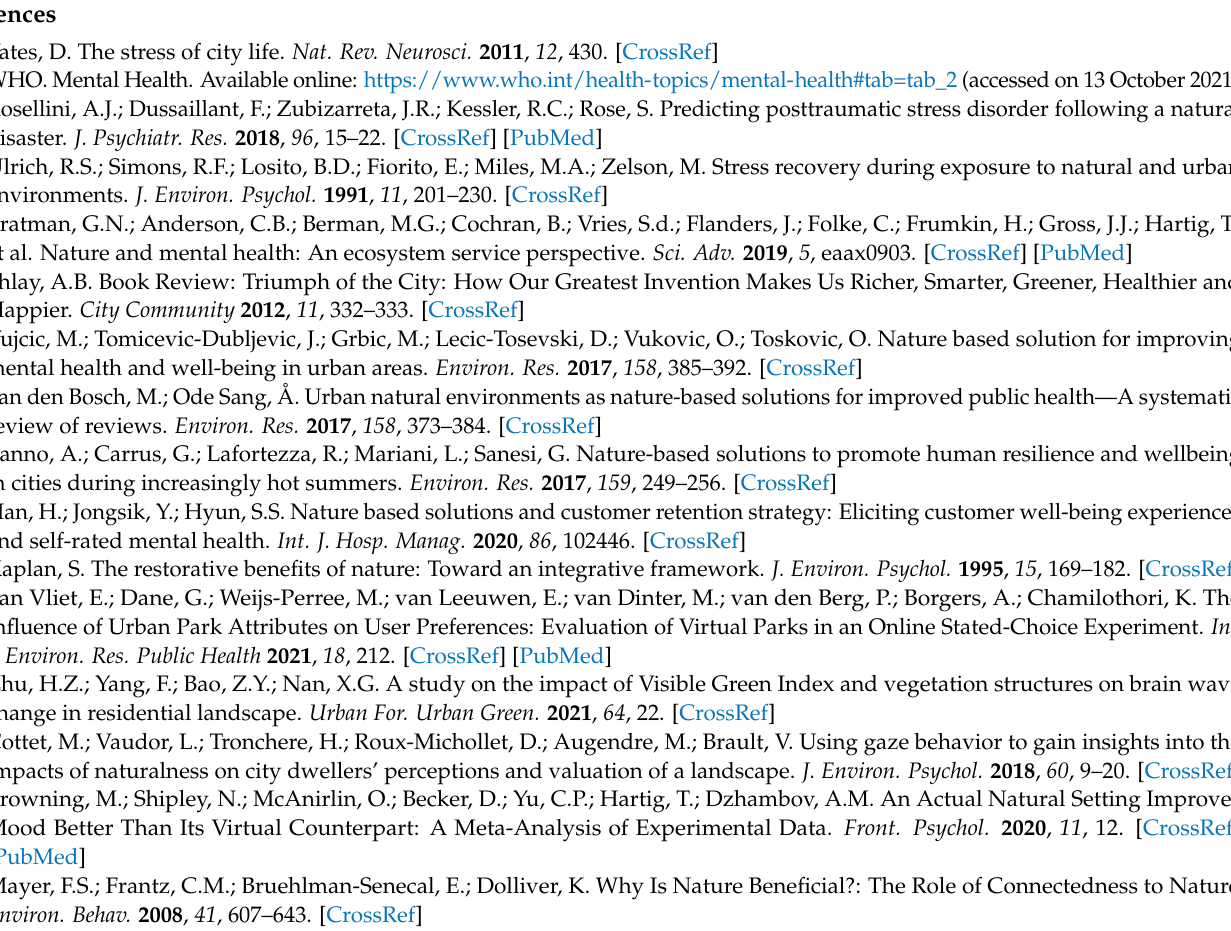
Figure S2: Spatial distributions of blue-space area ratios in wetland parks. Figure S3: Spatial distributions of elevations in wetland parks. Figure S4: Spatial distribution of green-space area in wetland parks. Figure S5: Spatial distribution of green-space area ratios in wetland parks. Figure S6: Spatial distribution of park area ratios in wetland parks. Figure S7: Spatial distribution of tree height in wetland